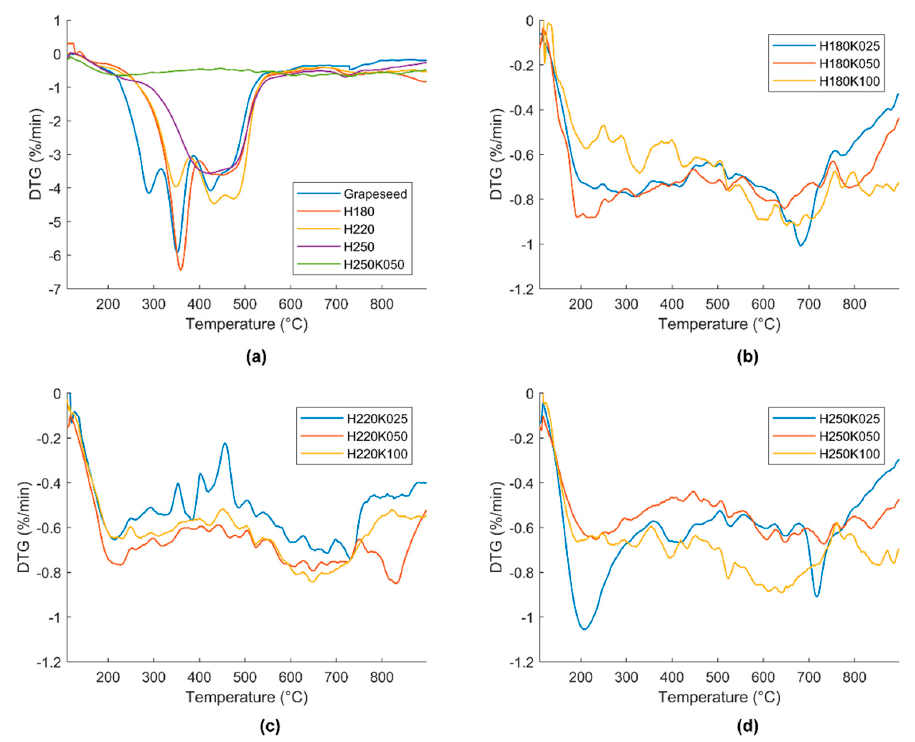
Figure 3. Thermal stability—derivative thermogravimetric curves versus temperature: ( a ) raw grape seeds, hydrochars and sample H250K050; ( b ) GSACs from hydrochar produced at 180 ◦ C; ( c ) GSACs from hydrochar produced at 220 ◦ C; and, ( d ) GSACs from hydrochar produced at 250 ◦